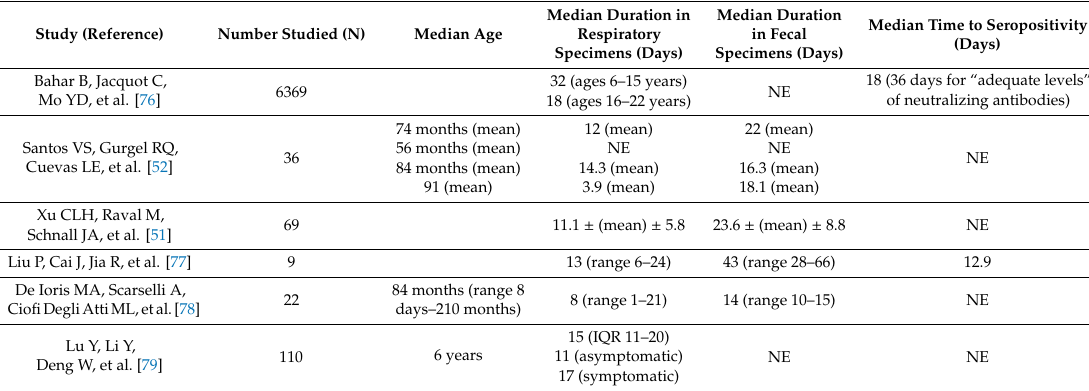
Table 2. Clinical Shedding of SARS-CoV-2 by pediatric COVID-19